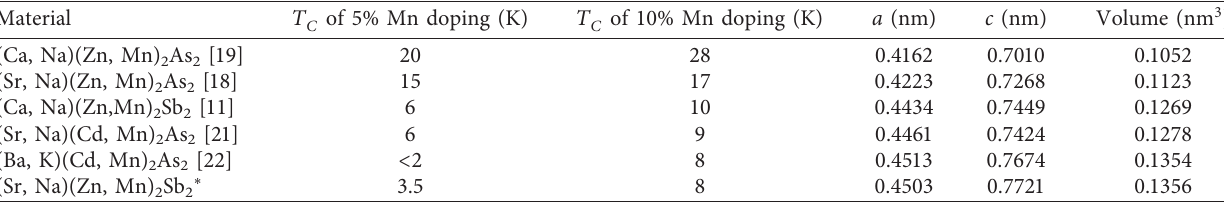
Table 3: The Curie temperature T C and parent compounds’ lattice parameters for different CaAl 2 Si 2 -type diluted magnetic semiconductors. Material T C of 5% Mn doping